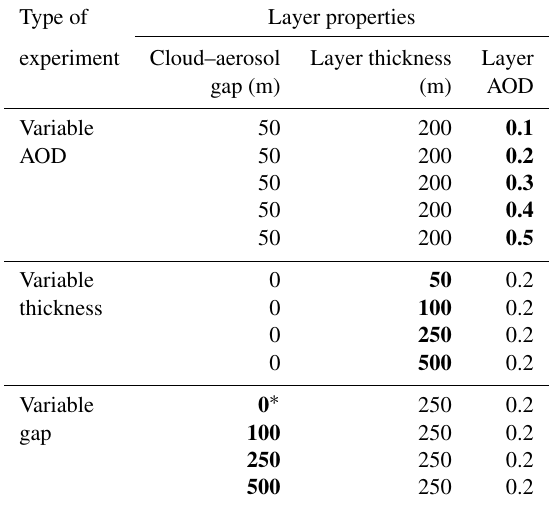
Table 2. Breakdown of all experiments performed. AOD stands for aerosol optical depth and is given at a mid-band wavelength of 505nm. Bold text emphasizes the variable that is being tested in each set of